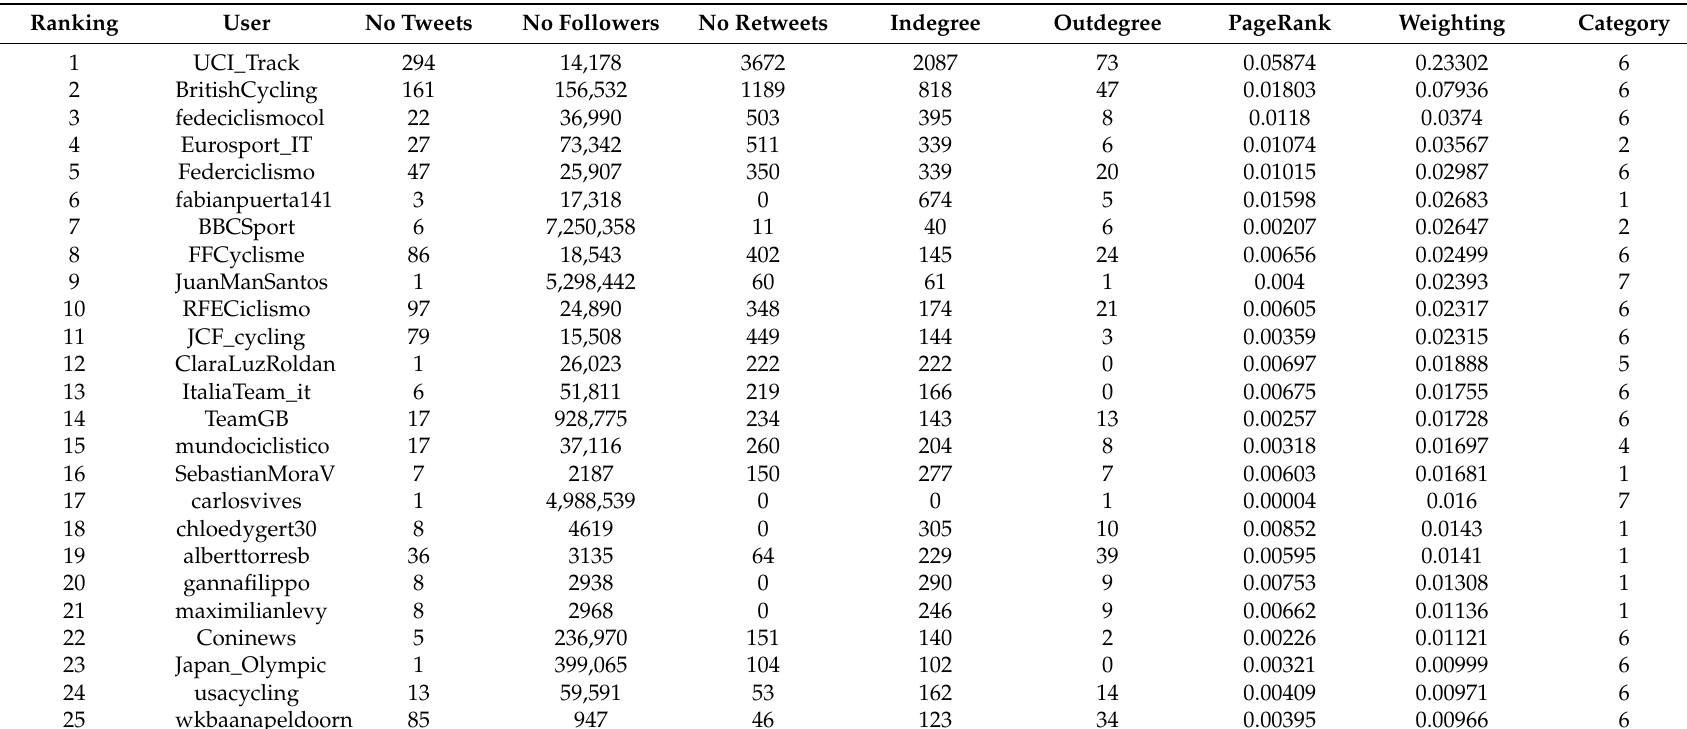
Table 7. The 25 most influential accounts with a breakdown by variable and group allocation. World Championship